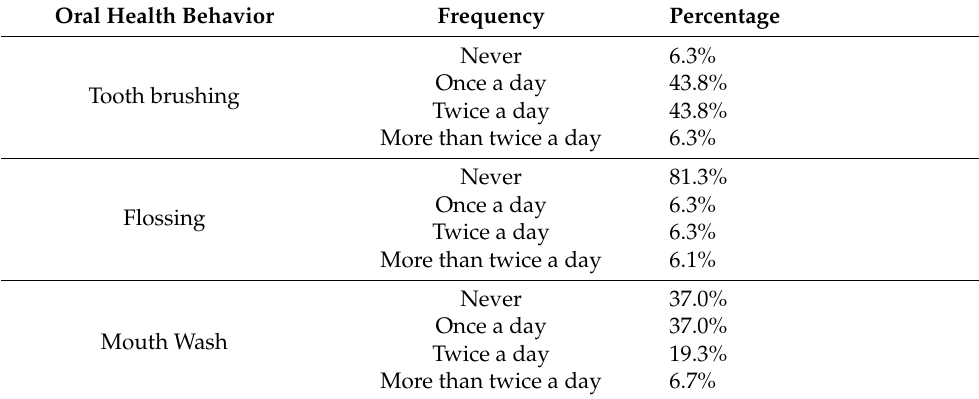
Table 2. Children Tooth brushing Behavior.